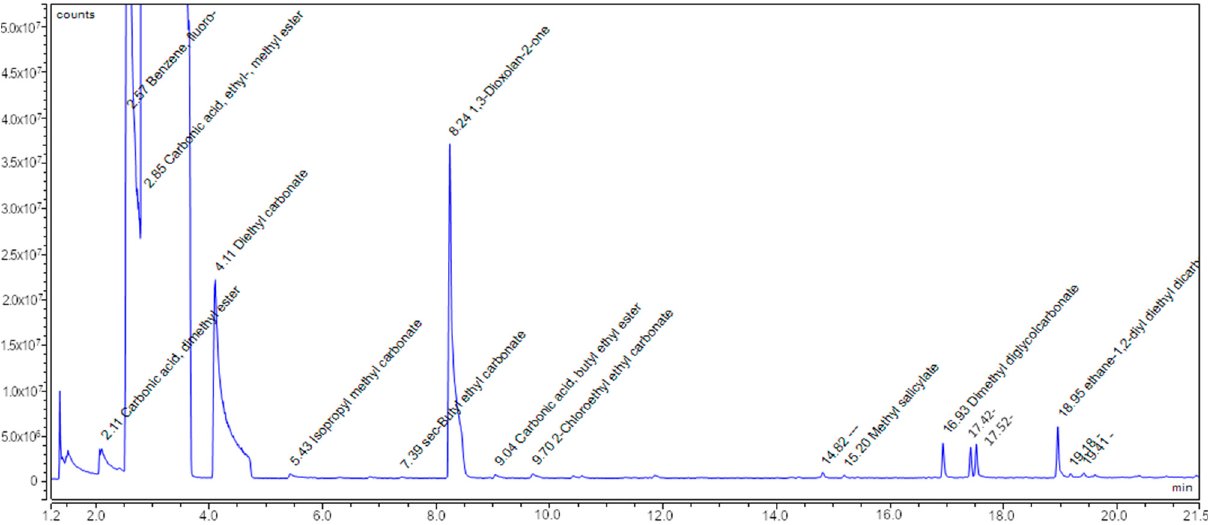
Figure 10. SPME extraction of volatile solvents from aqueous solution, further identification of trace carbonates.